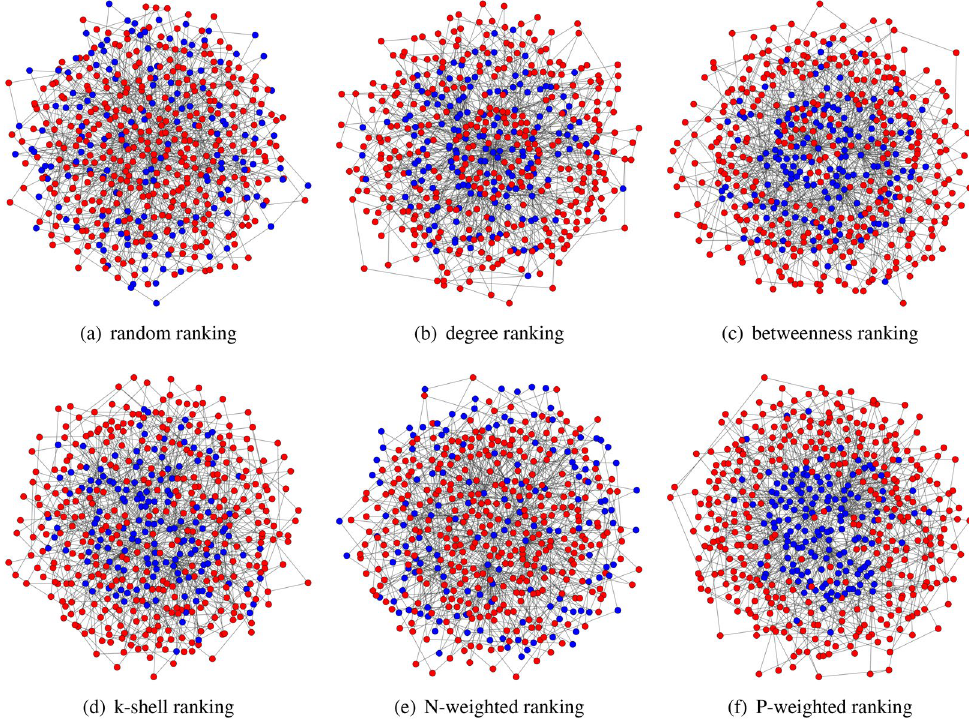
Figure 2. The initial positions of cooperators in a scale-free structure. The cooperators are more likely to be around the hubs when the rankings are P-weighted degree, k-shell or betweenness; however it is more likely for cooperators to be kept far away from each other when they are added using the ranking of N-weighted degree or random. We consider an initial density of ρ = 30% , and cooperators are added in a network of cheaters by using the random, degree, betweenness, k-shell, N-weighted and P-weighted